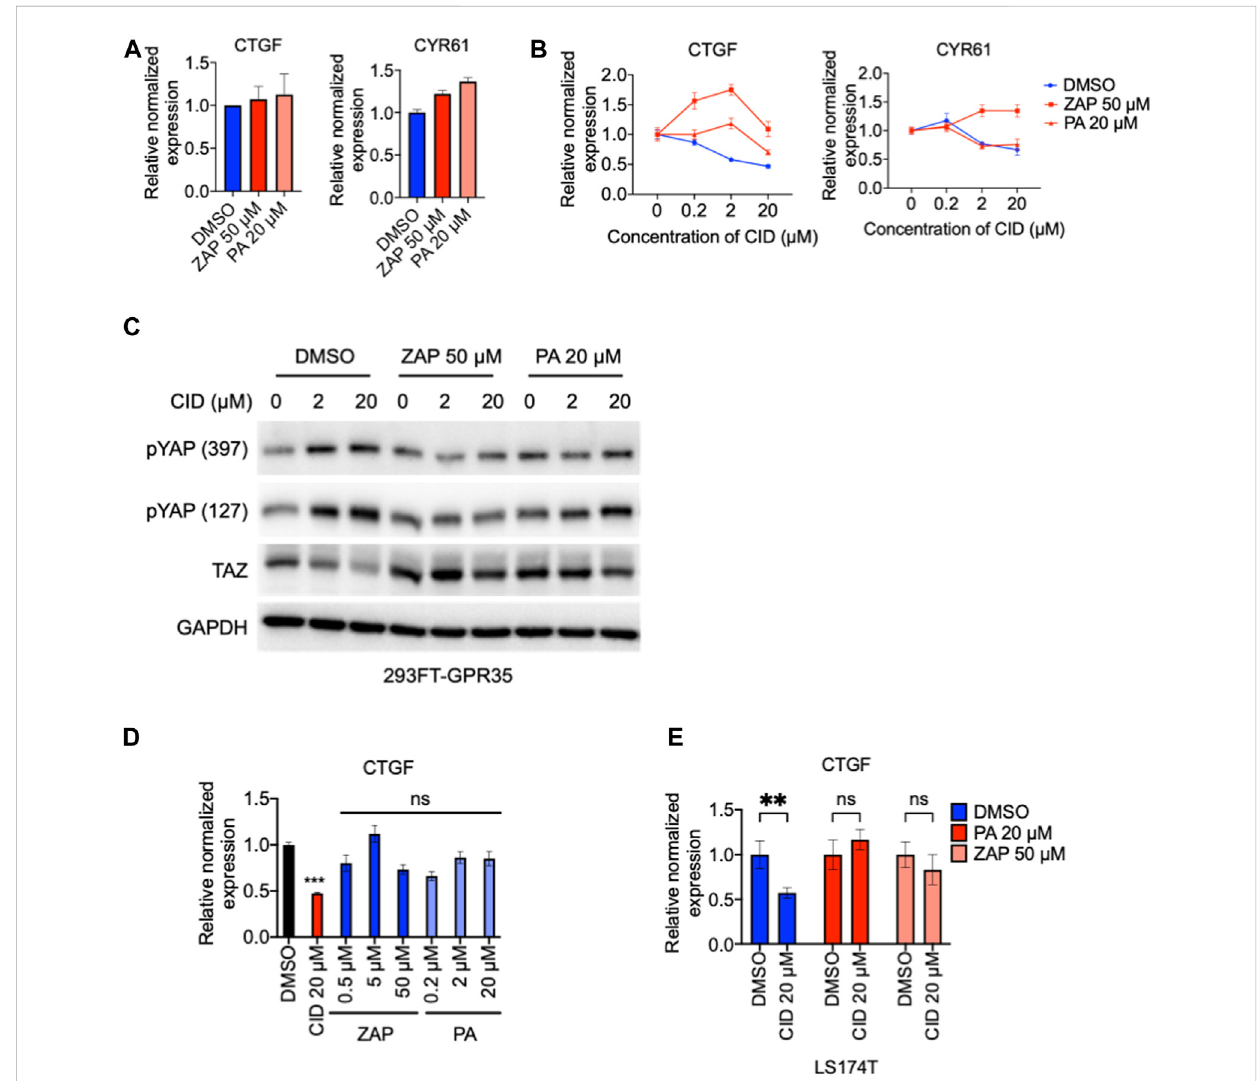
FIGURE 8 GPR35 agonists did not promote YAP/TAZ activity but attenuated the regulatory effect of CID-2745687. 293FT cells were infected with GPR35 expression lentivirus at different ratios of 1:20 for 24 h, and 50 μ M zaprinast or 20 μ M pamoic acid were added directly to the medium. (A) mRNA expression of YAP/TAZ target genes after treatment of 50 μ M zaprinast or 20 μ M pamoic acid. (B) mRNA expression of YAP/TAZ target genes after treatment of pamoic acid combined with different concentrations of CID. (C) Western blot analysis of YAP phosphorylation and TAZ expression. 293FT cells were infected with GPR35 expression lentivirus at different ratios of 1:10 for 24 h, and indicated concentrations of agonists were added directlytothemedium.After1 hofincubation,differentconcentrationsofCIDwereadded.Cellswereharvestedforanalysisafter24 hofdrugtreatment. (D) mRNA expression of CTGF, LS174T cells were exposed to indicated treatments for 12 h, and harvested for analysis. (E) mRNA expressionof CTGF and CYR61 in LS174T cells after 12 h of agonists treatments with or without 20 μ M of